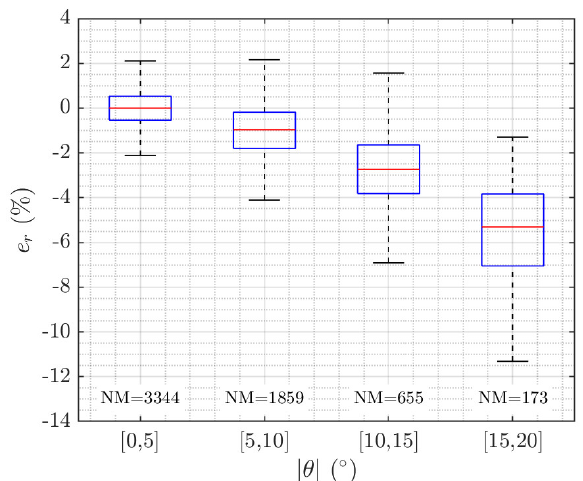
Figure 9. Relative error (e r ) between acoustic–optical (AO) and stereoscopic measurements depending on the swimming tilt angle ( θ ). NM: number of measurements.